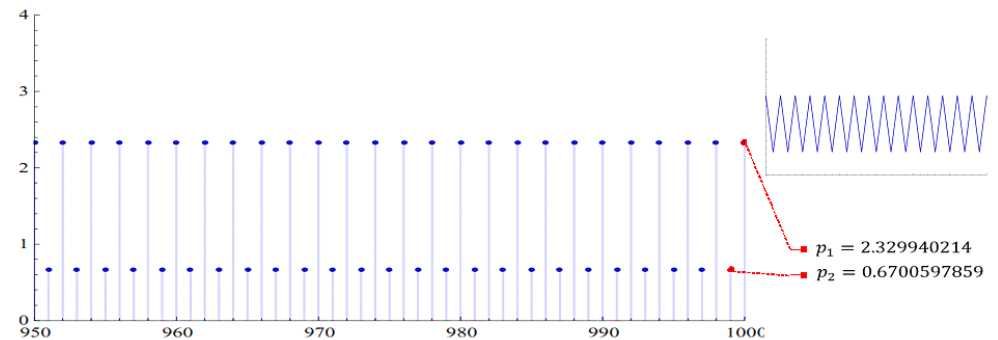
Figure 4. Prime period 2